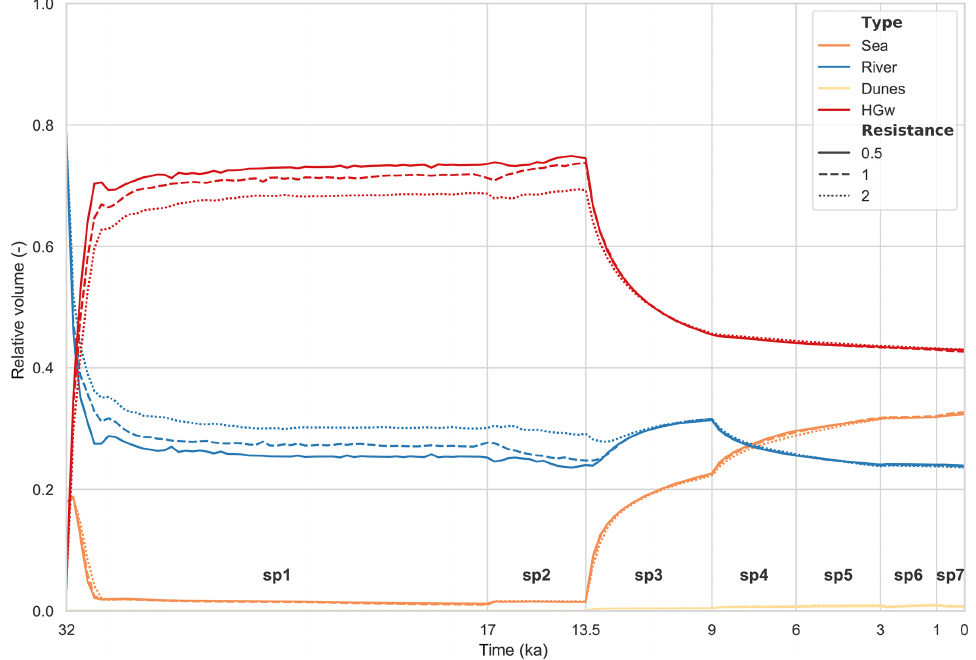
Figure B1. Groundwater origins for scenario “H-N-T-P” with three resistances. The colour indicates the groundwater type, the line style the value the original resistance is multiplied by. Stress period numbers are indicated in bold with